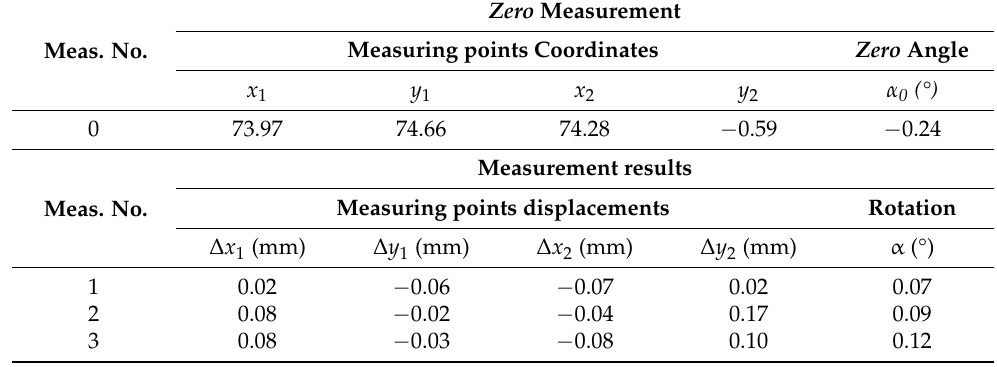
Table 9. Crack C measurement